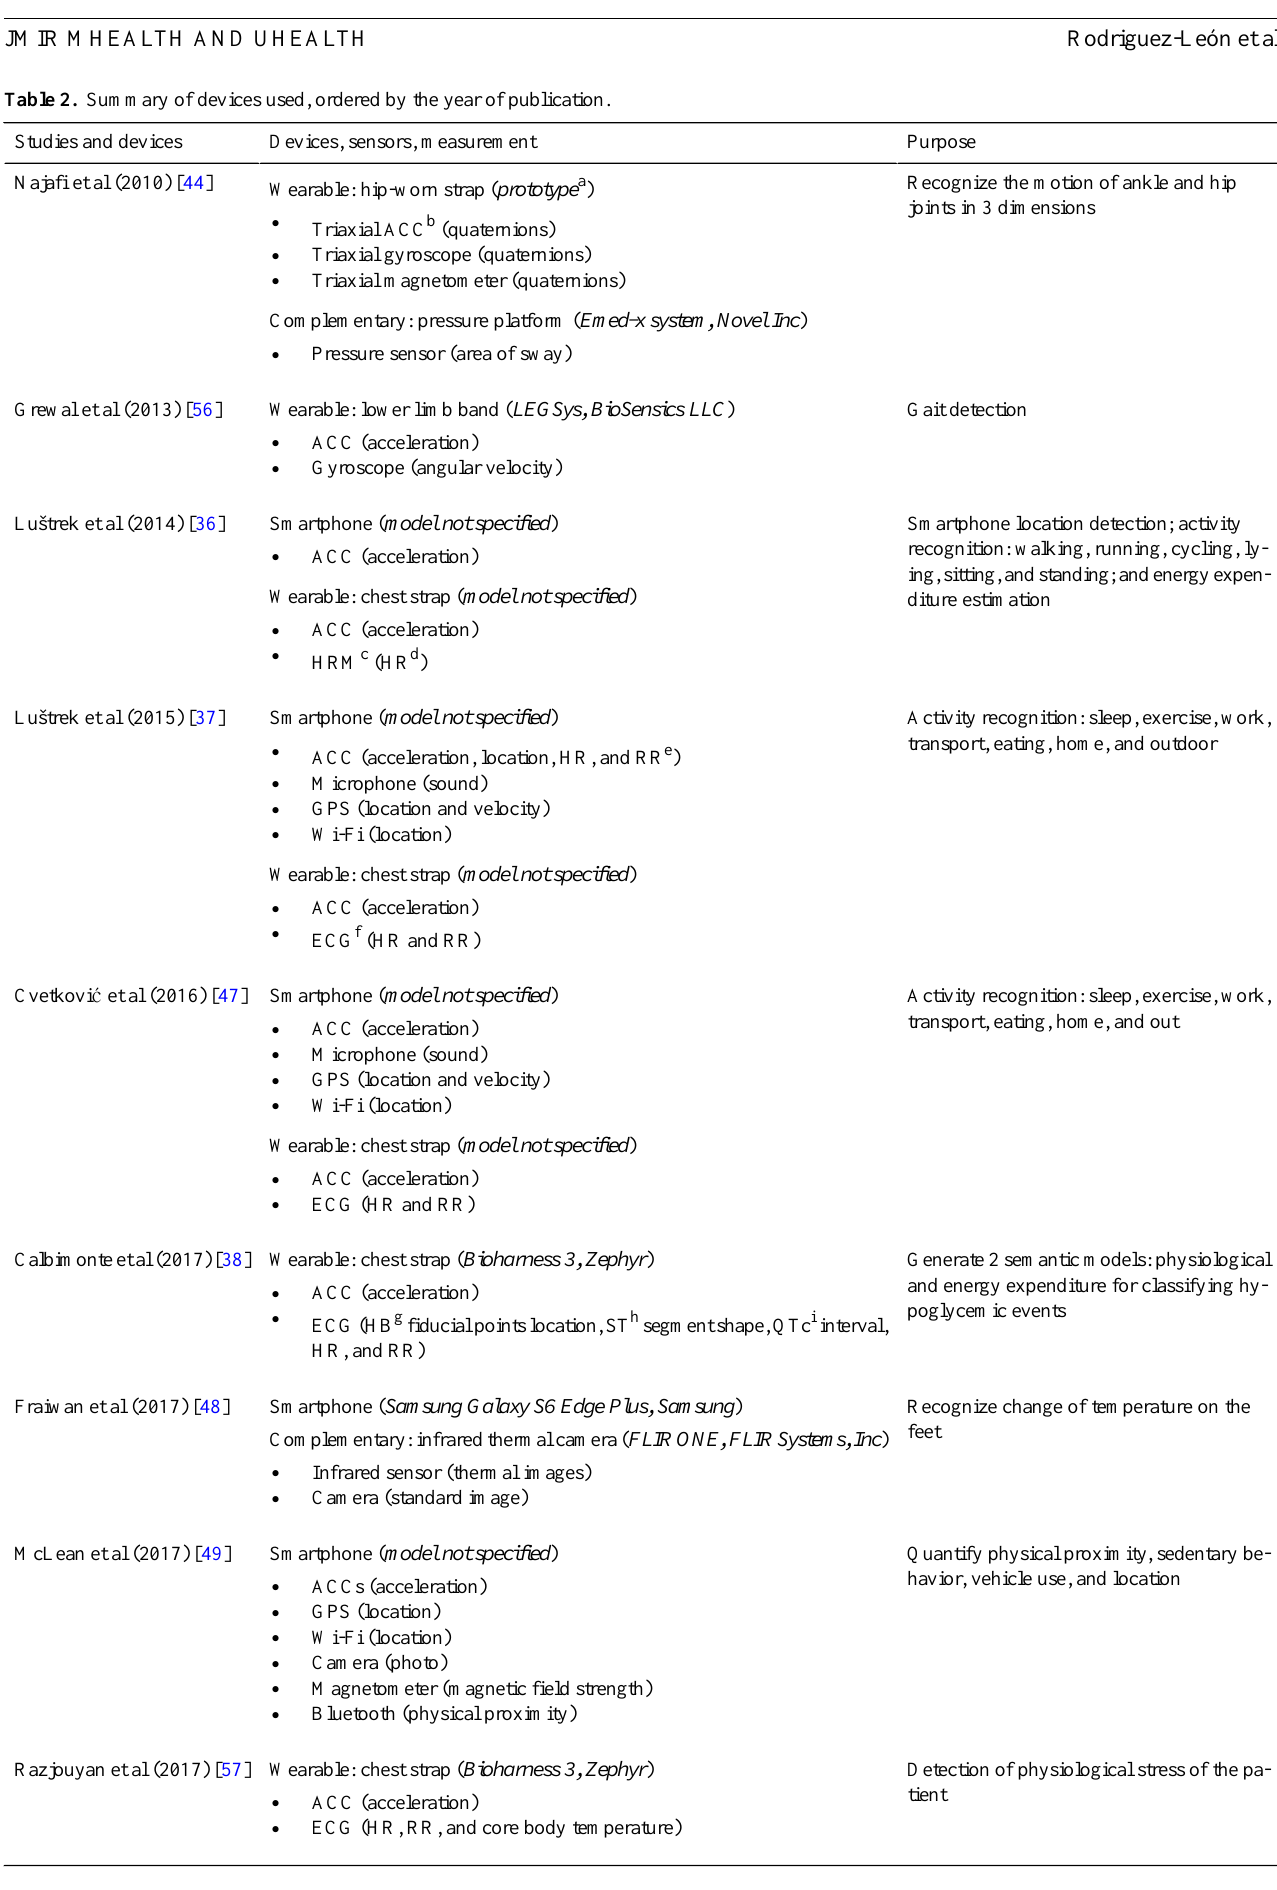
Recognize the motion of ankle and